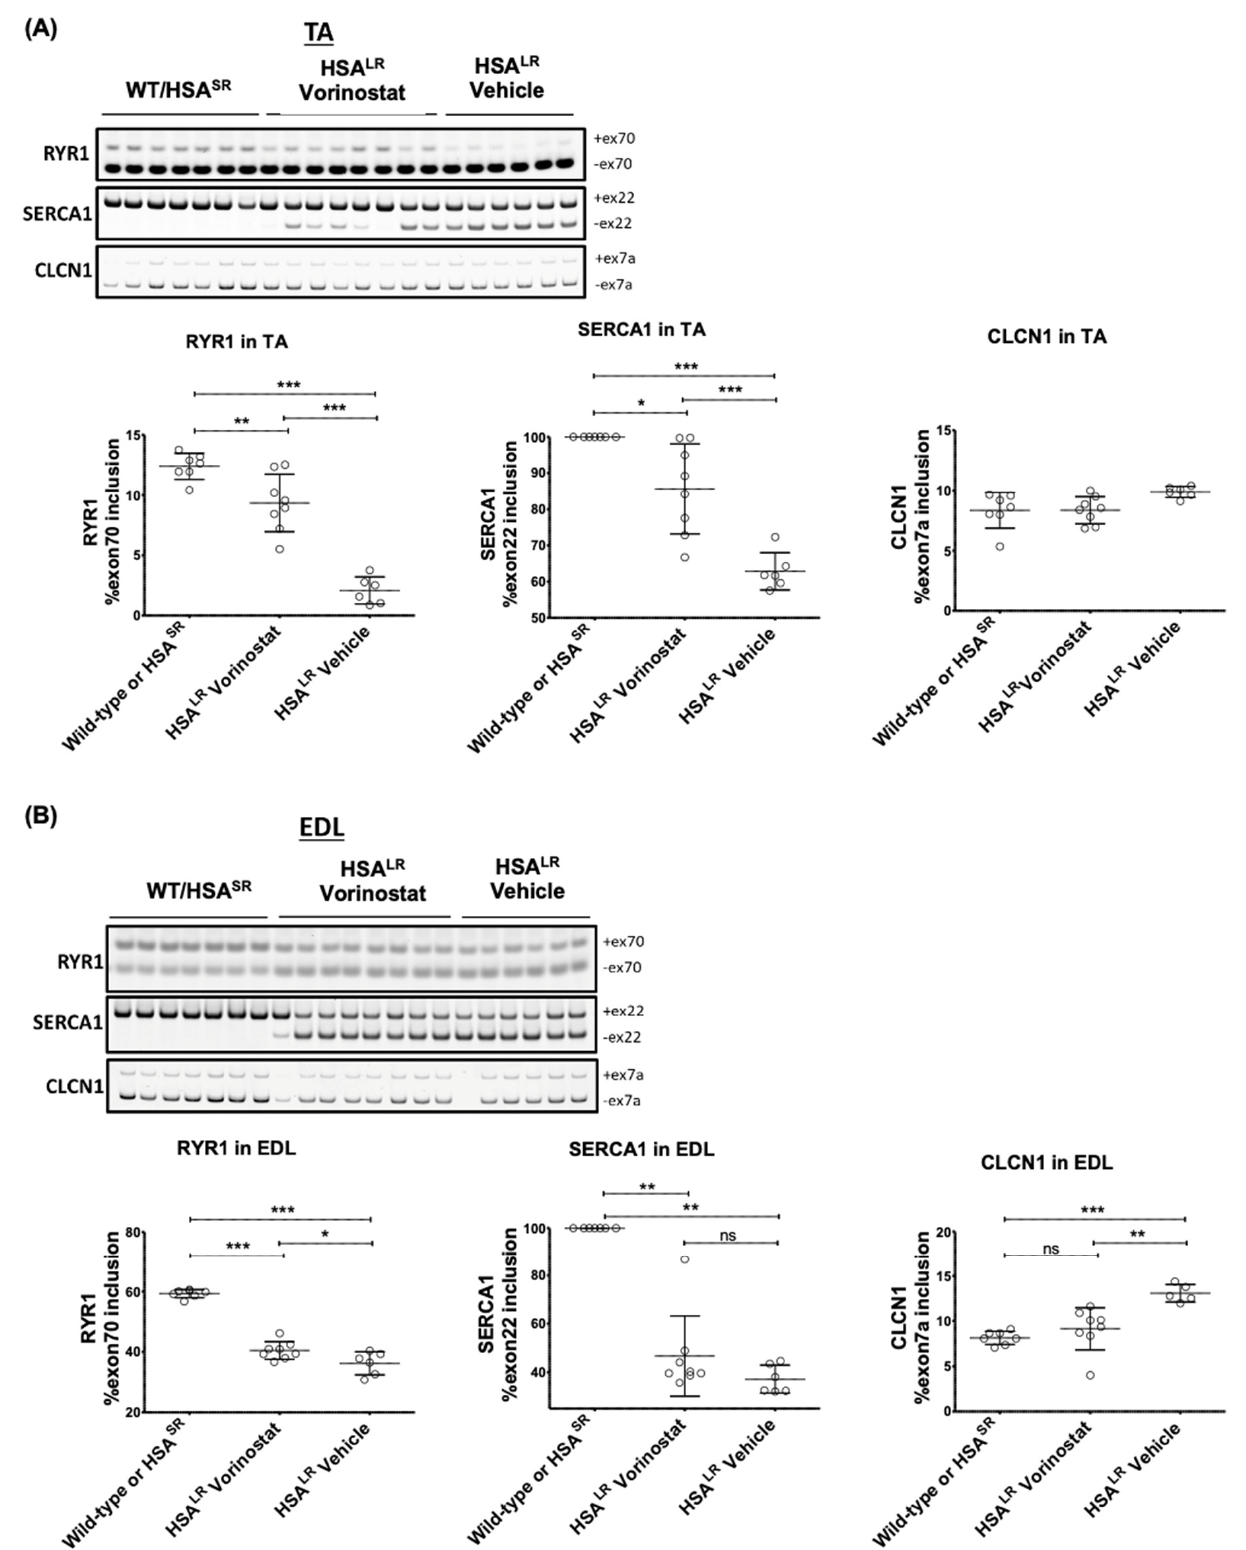
Figure 6. Vorinostat (SAHA) showed promising therapeutic effects in the DM1 HSA LR mouse model, with greater impact in TA than EDL. Mice at approximately 4 weeks of age were injected (IP) daily with vehicle or 50 mg/kg vorinostat (SAHA) for 4 weeks. The mice were sacrificed by lethal injection and cervical dislocation. Skeletal muscle tissue from one hind leg was frozen in OCT for sectioning and imaging, and skeletal muscle tissue from the other hind leg was flash frozen in liquid nitrogen for RNA workup. Analysis of DM1 related spliceopathy. Flash frozen tissue was ground to a pow- der and a portion used for Trizol RNA extraction using 5 the Purelink RNA mini kit (Invitrogen) and reverse transcribed to cDNA (iScript Advanced RT kit, BioRad). RT-sqPCR products using cDNA from ( A ) TA and ( B ) EDL were resolved on 7% acrylamide gel, stained with Gel Red and imaged using the ChemiDoc (BioRad). Quantification of transcript ratios was done using ImageLab